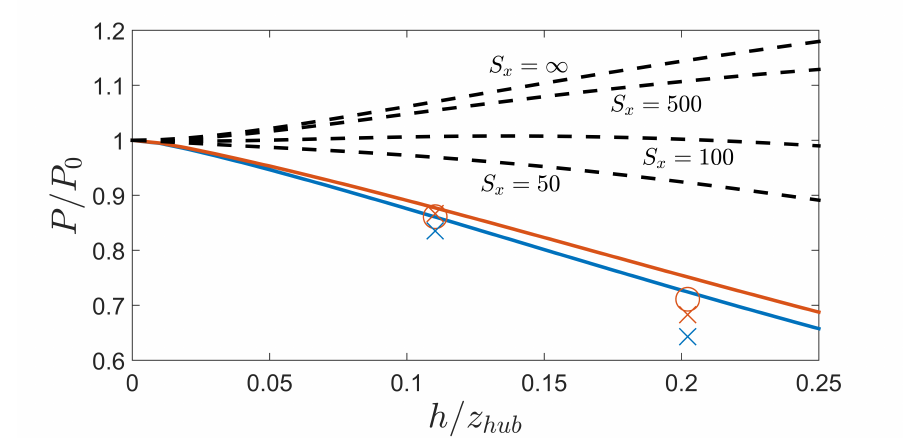
Figure 5. Power output predictions based on the top-down model along with LES data. Blue markers indicate S x = 6, and red counterparts denote S x = 10; × s indicate aligned arrangement, and circles indicate staggered wind farm.